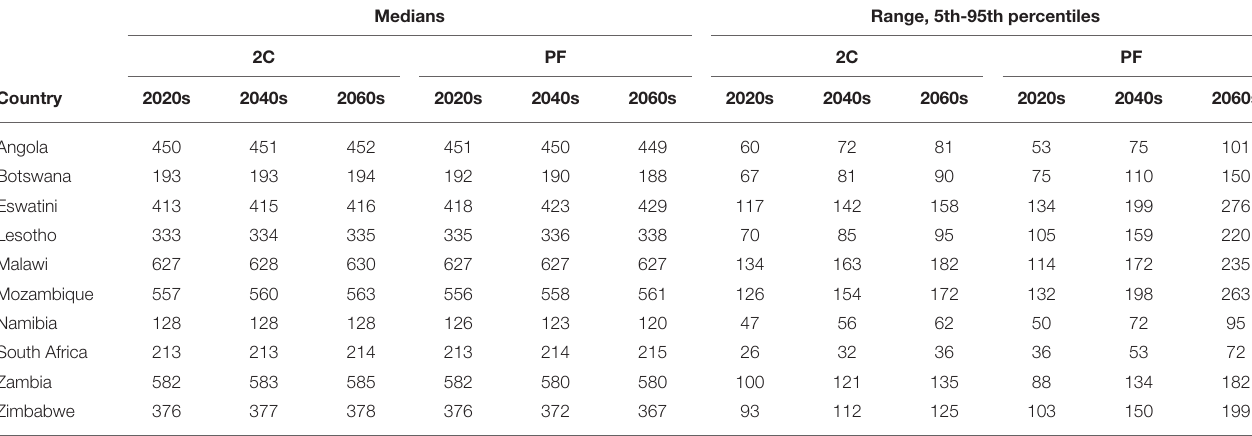
TABLE 1 | Median precipitation and variation for the wettest 3 months across climate models and multiple years in selected decades, in millimeters. Medians Range, 5th-95th percentiles